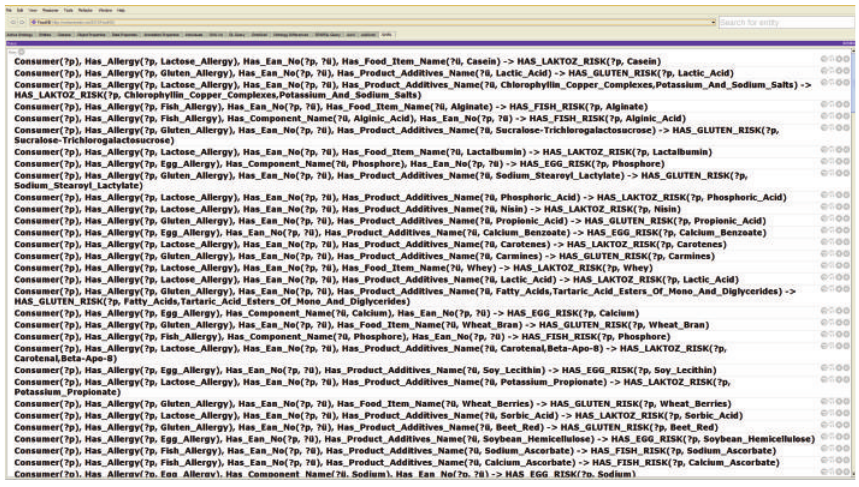
Figure 7: SWRL rule set of the